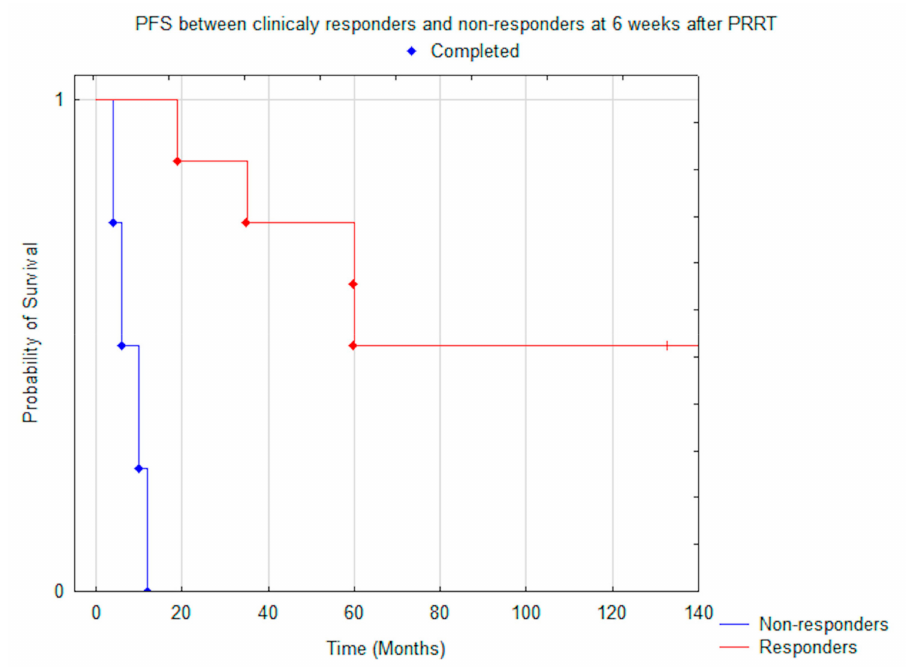
Figure 5. Comparison of median PFS between clinically responders ( n = 8) and non-responders ( n = 5) at six weeks after PRRT ( p = 0.0004).